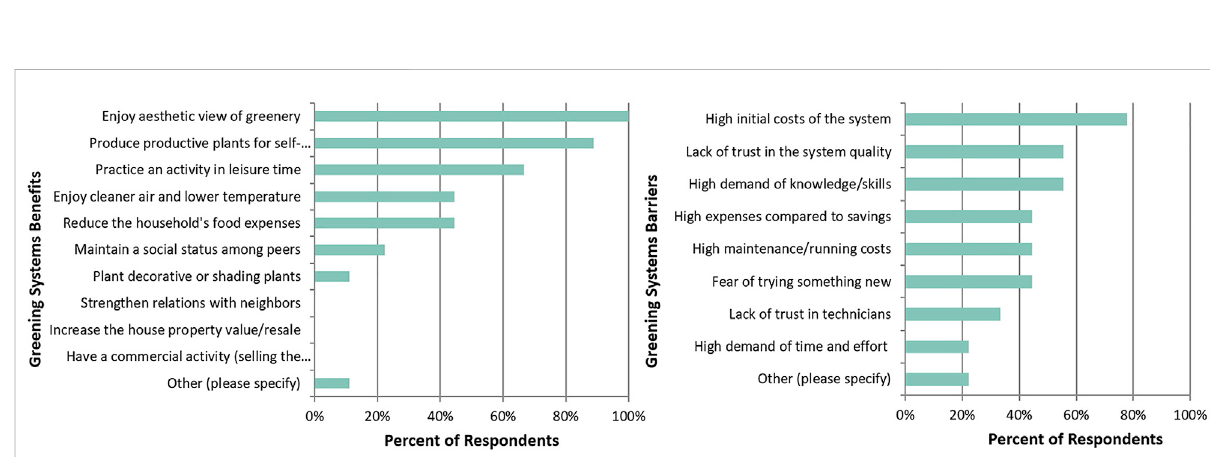
FIGURE 6 Results from the online survey showing the opinions of greening systems ’ experts and suppliers about the customers ’ perceptions of the main bene fi tsandbarriersfacingthesystems( n =12outof15totalrespondents).Therespondentswereaskedtoselectthefourmostimportantoptionsin each question (X = 35 total responses for the bene fi ts question and X = 36 for the